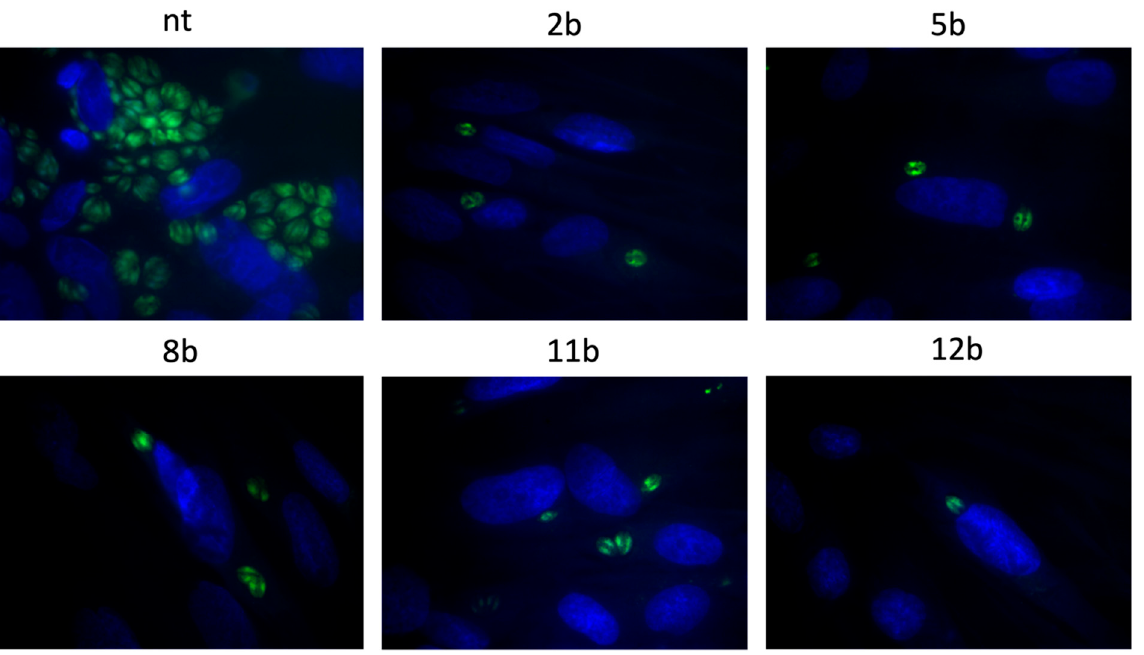
Figure 7. Representative images from Assay A. Host cells infected with tachyzoites for 3 h in the milieu of the 1,3,4-thiadiazoles 2b , 5b , 8b , 11b or 12b and then washed, incubated for 24 h in free medium; T. gondii —green, cell nuclei—blue; NT—non-treated.